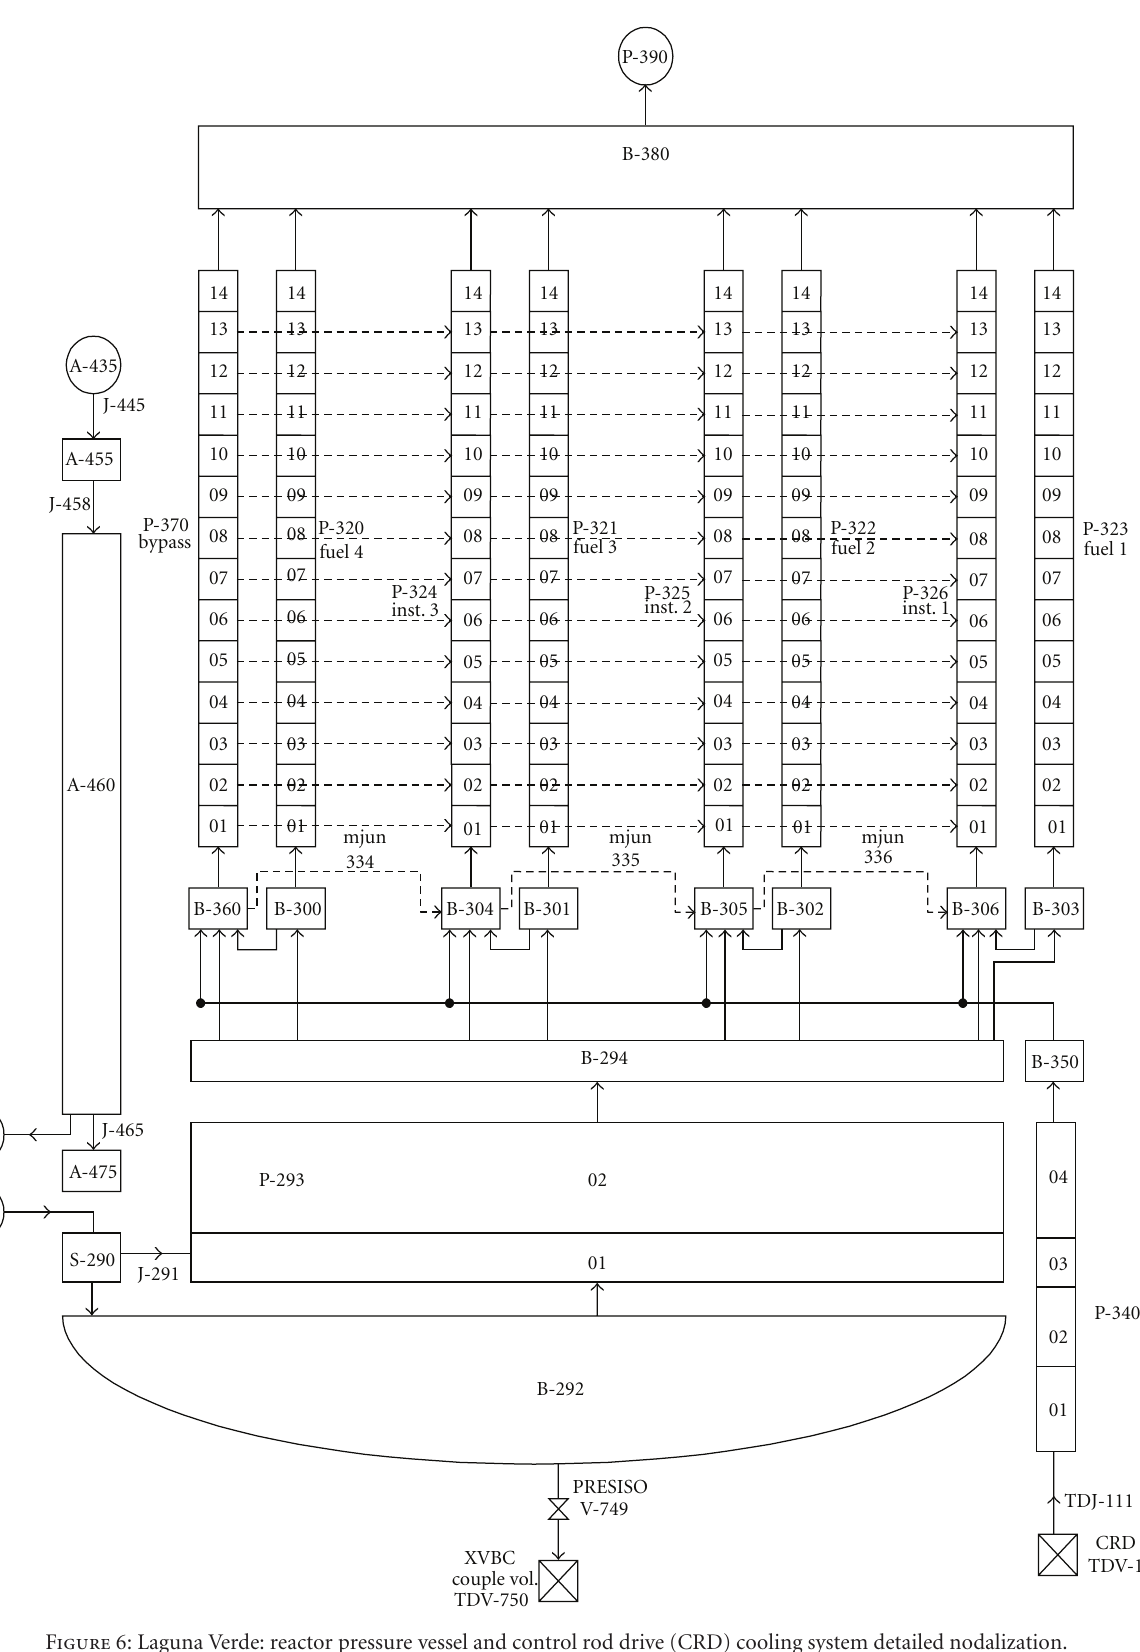
Figure 6: Laguna Verde: reactor pressure vessel and control rod drive (CRD) cooling system detailed